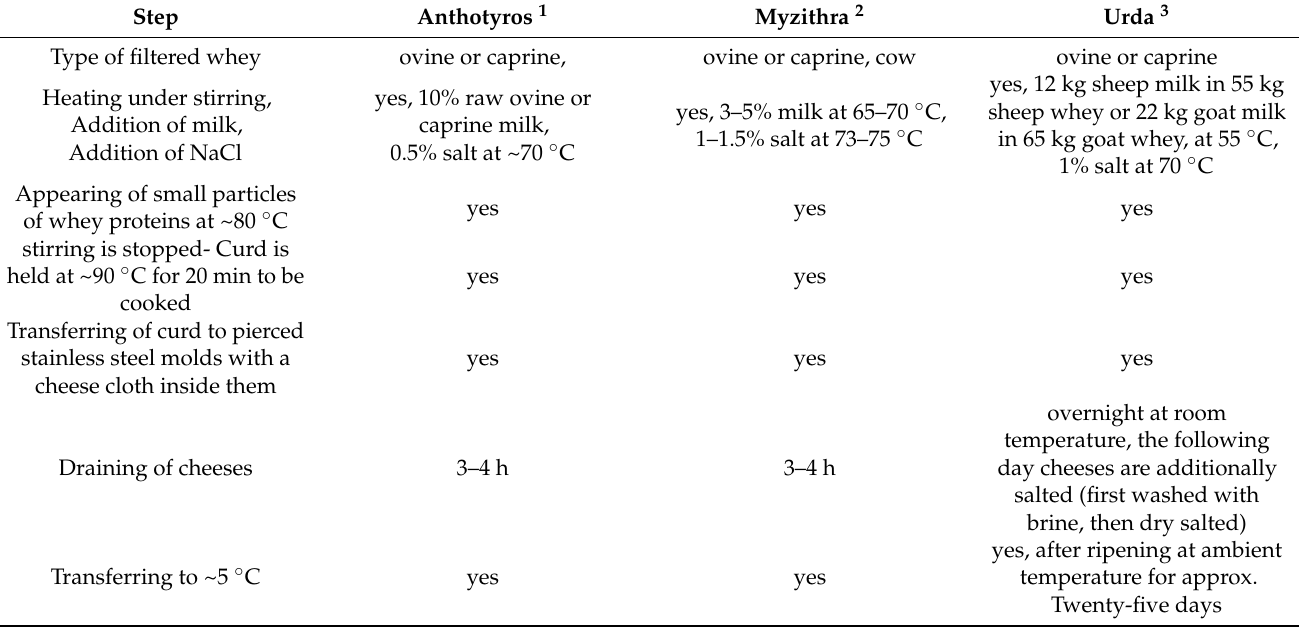
Table 11. Manufacturing technology of nonprotected designation of origin and nonprotected geo- graphical indication whey